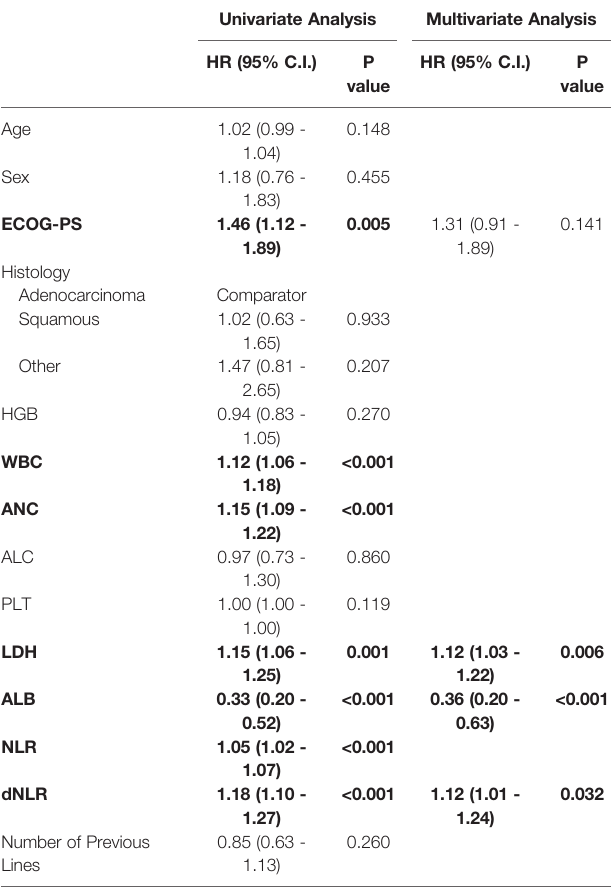
TABLE 2 | Univariate and multivariate analysis for OS of the parameters investigated. Univariate